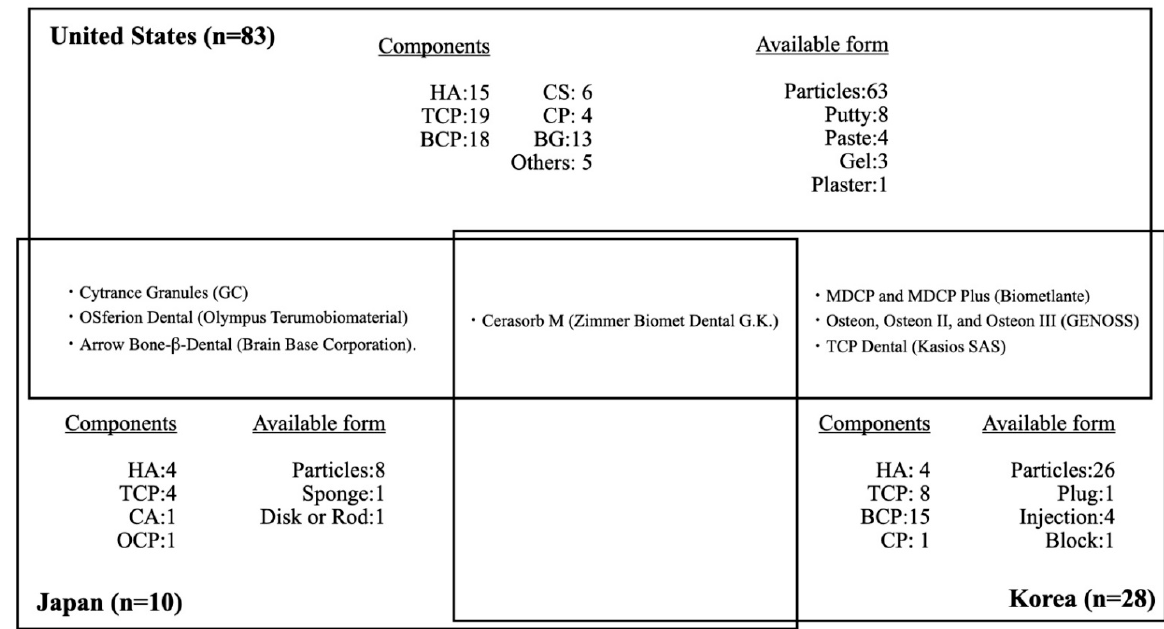
Figure 3. Distribution of dental alloplastic bone substitute products commercially available in the United States, Japan, and Korea. HA = hydroxyapatite, TCP = tricalcium phosphate, BCP = biphasic calcium phosphate, CS = calcium sulfate, CP = calcium phosphate, BG = bioglass, CA = carbonate apatite, OCP = octacalcium phosphate.